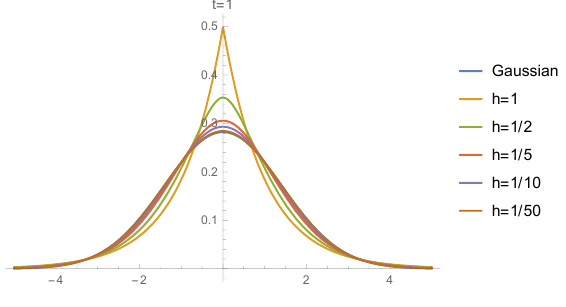
Figure 1. Behavior of Gauss kernel G 1